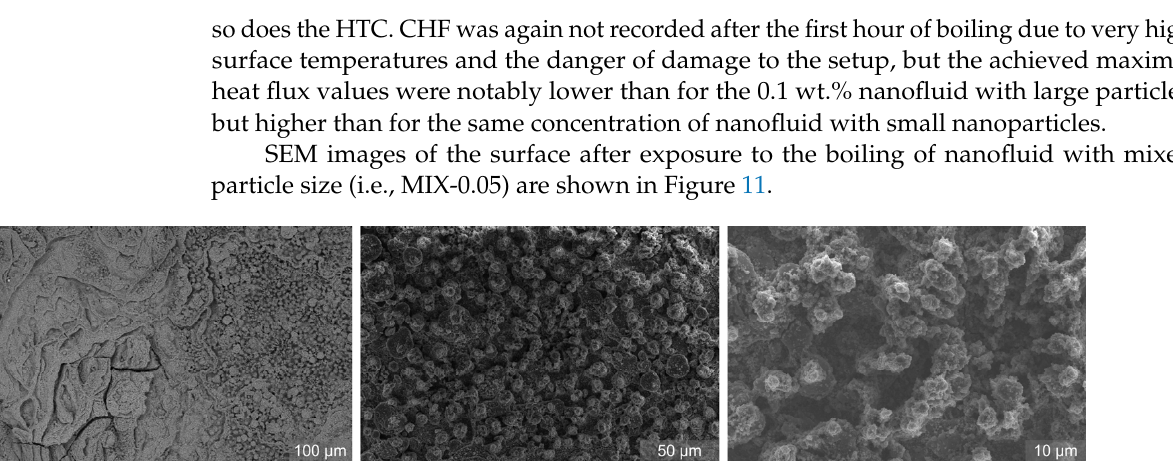
Figure 11. SEM images of the laser-textured sample LT after exposure to boiling of nanofluid with a mixture of 0.05 wt.% of small nanoparticles and 0.05 wt.% of large nanoparticles (i.e., MIX-0.05).